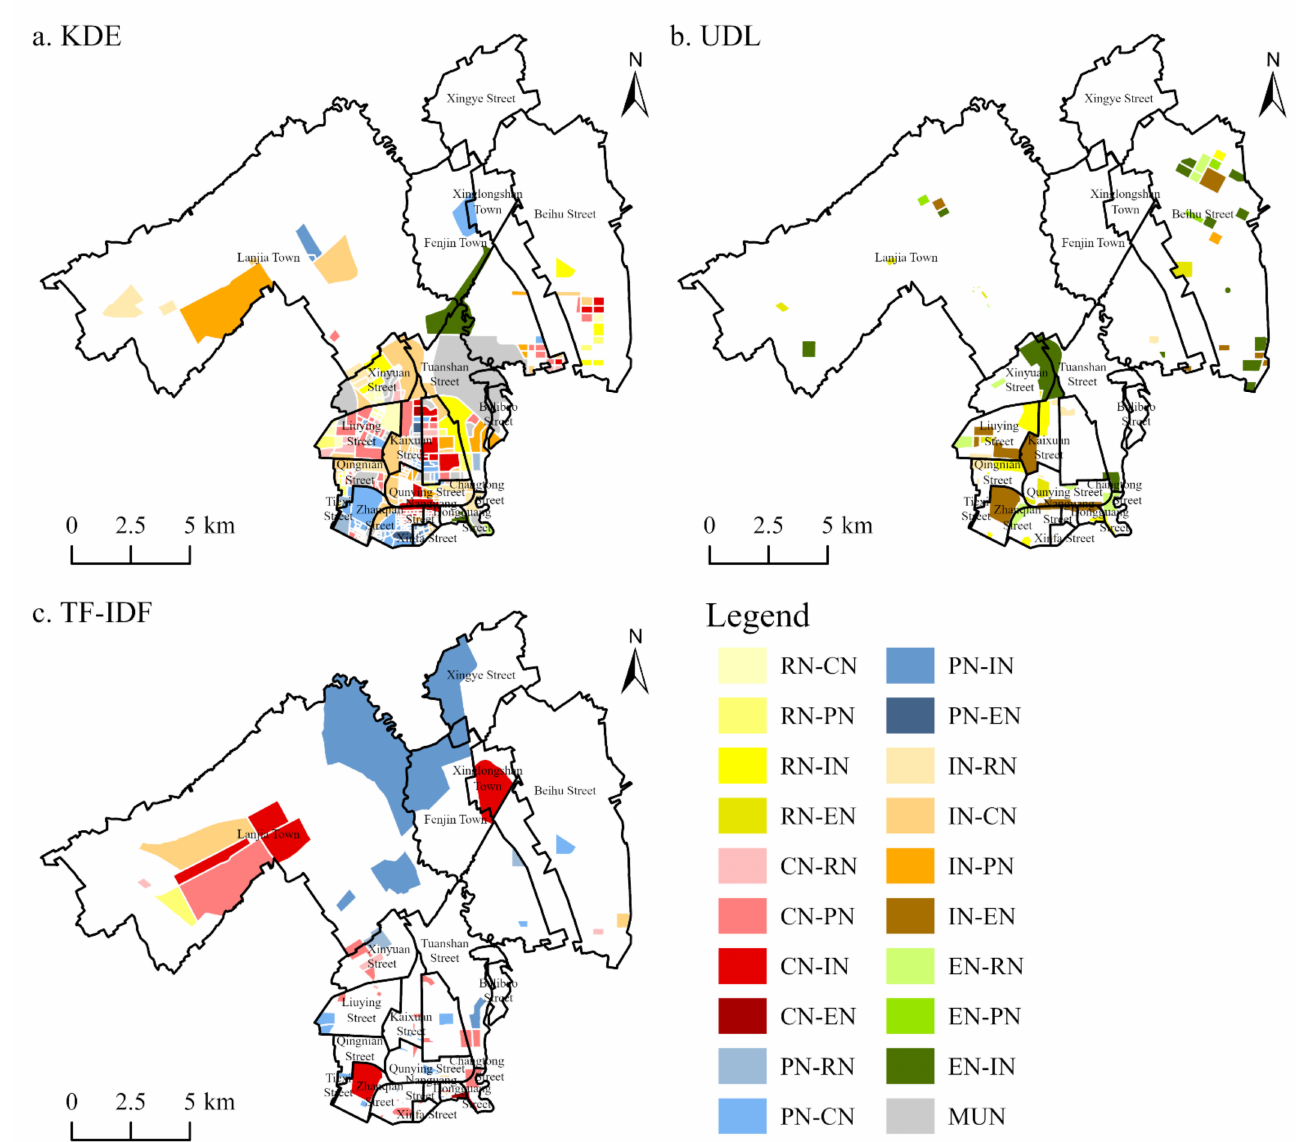
Figure 5. Spatial distribution of mixed functional zones in Kuancheng District predicted by ( a ) Size KDE, ( b ) UDL, and ( c )